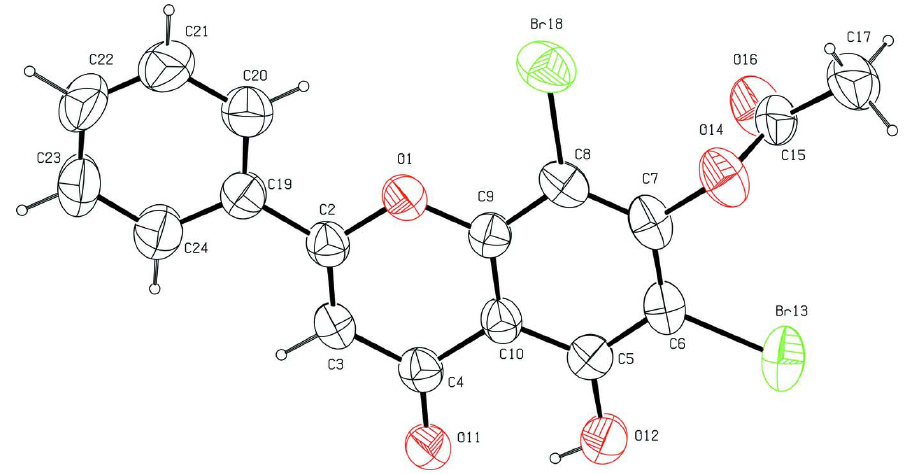
The asymmetric unit with the atoms labelled and displacement ellipsoids depicted at the 50% probability level for all non-H atoms. H-atoms are drawn as spheres of arbitrary